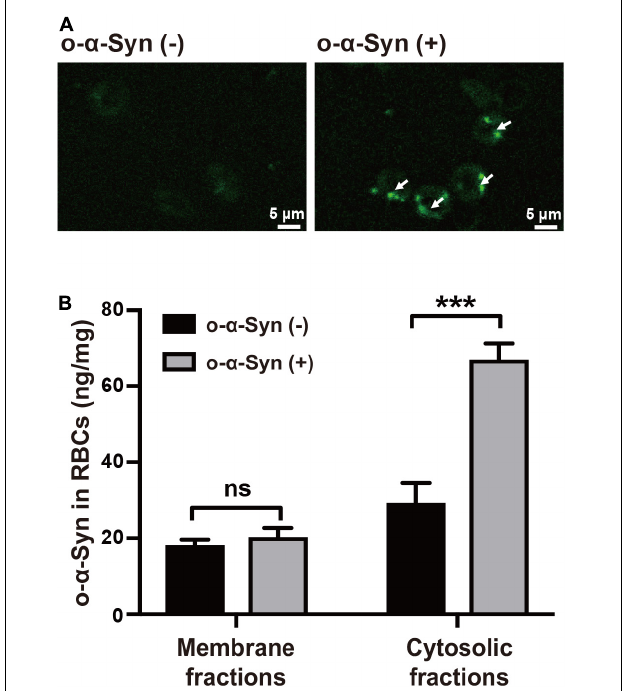
FIGURE 3 | o- α -Syn transport into isolated RBCs. (A) Confocal microscopic analysis showed that o- α -Syn-treated RBCs had α -Syn-immunoreactive fluorescent particles in the outer region of RBCs (scale bar = 5 µ m). (B) Significant increase in o- α -Syn levels was only detected in the cytosolic fraction and not the membrane fraction. n = 3; *** p <